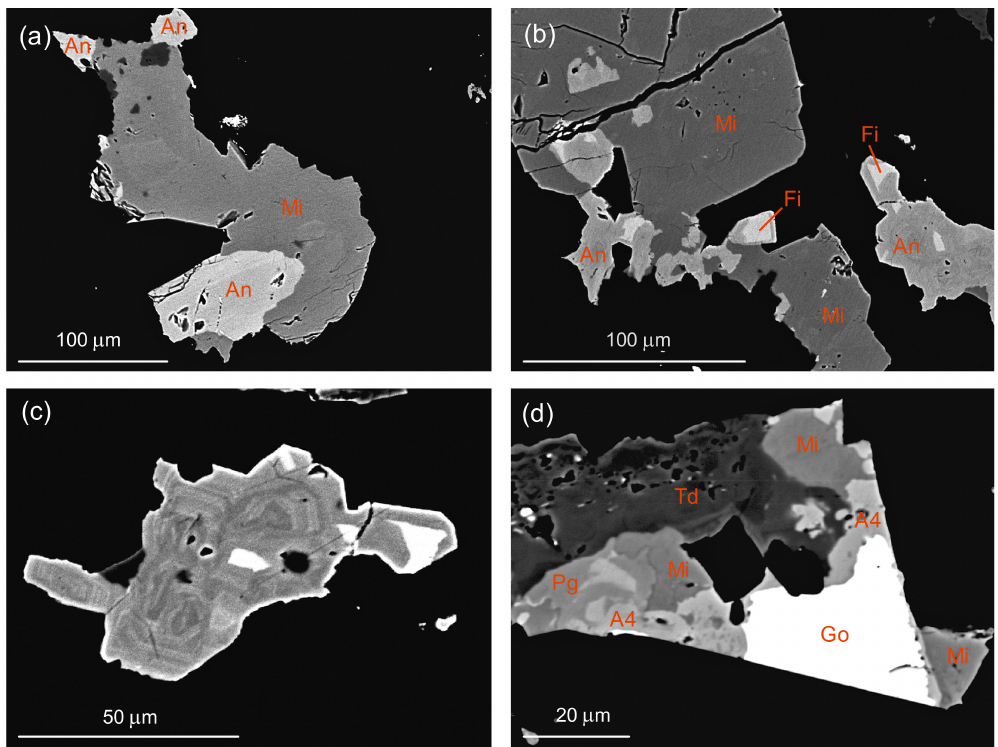
Figure 22. ( a ) Andorite VI (An) associated with miargyrite (Mi); ( b ) andorite VI (An) intergrown with Ag-excess fiz é lyite (Fi) and miargyrite (Mi); ( c ) zonal andorite VI aggregate with inclusions of Ag-excess fiz é lyite (white); ( d ) aggregates of andorite IV (A4) in association with gold (Go), miargyrite (Mi), pyrargyrite (Pg), and Ag-rich tetrahedrite (Td); all back-scattered electron (BSE)